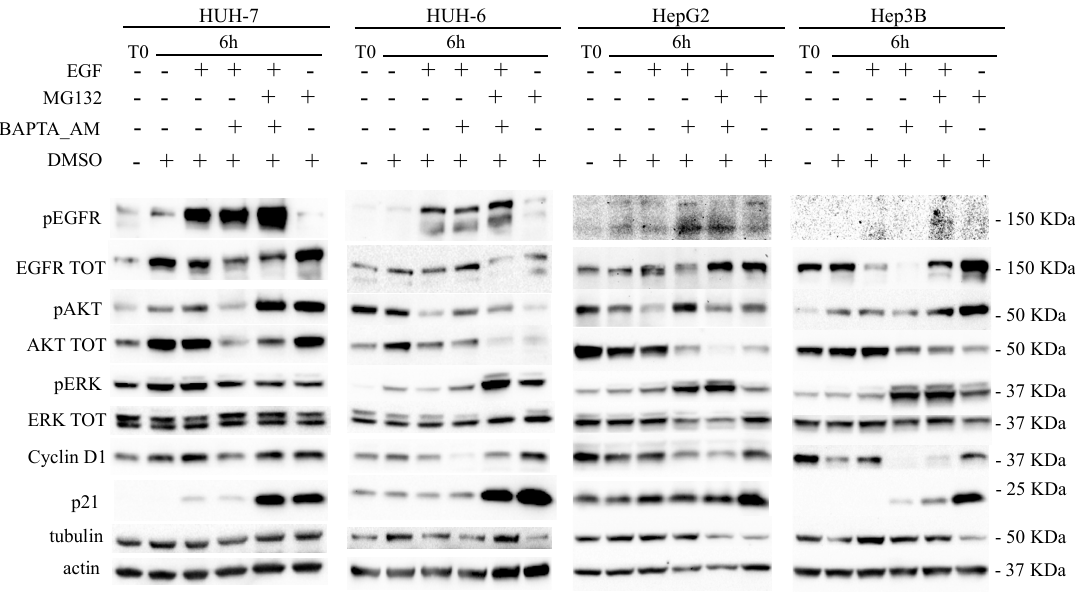
Figure 10. Starved HUH-7, HUH-6, HepG2, and Hep3B cells (T0) were left untreated (as CTR) or treated with 10 µM BAPTA_AM. After 30 min, 40 µM MG132 were added for a further 30 min. 100 ng/mL EGF were added for a total time of 6 h before cells harvesting.